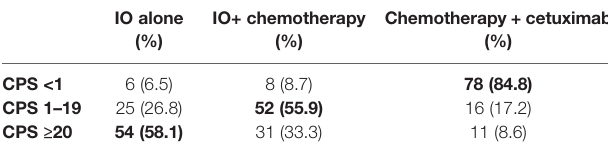
TABLE 7 | Clinical Case 5 — Preferred therapy according to CPS